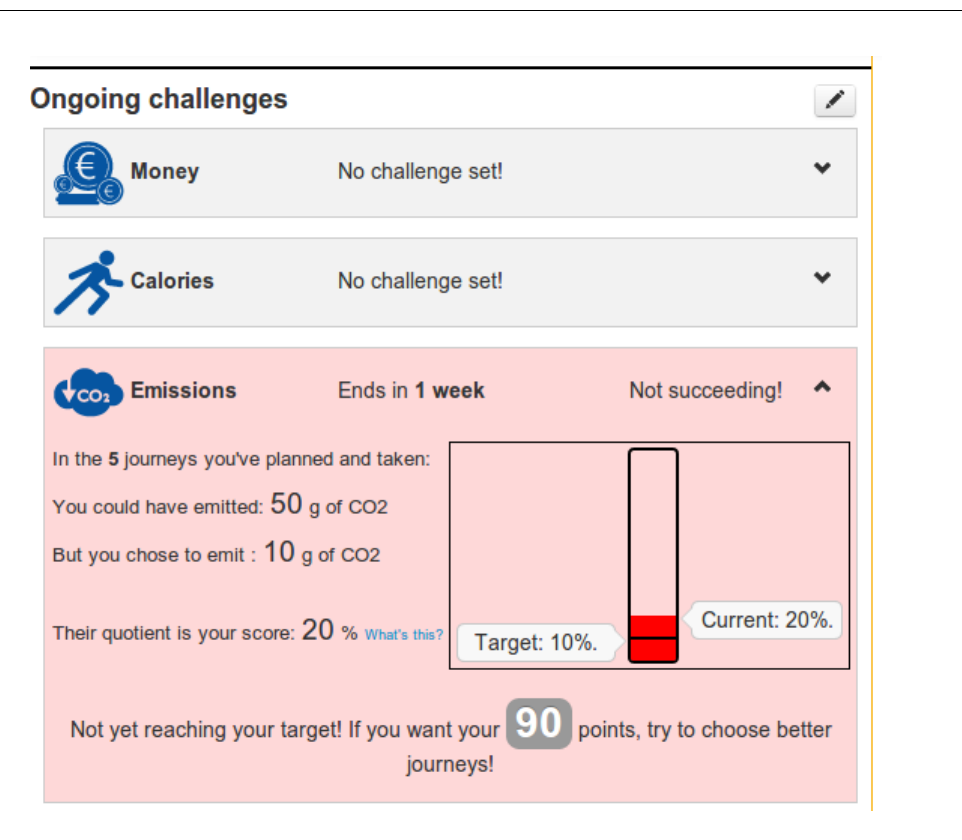
Figure 4. This figure illustrates the challenge screen that is displayed to the user when they are failing a challenge.